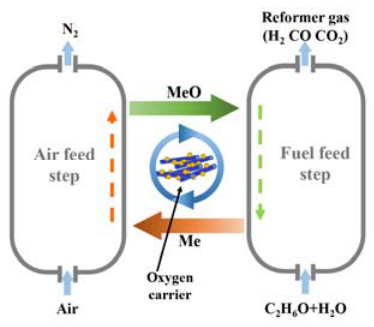
Figure 1. Schematic diagram of chemical looping process.